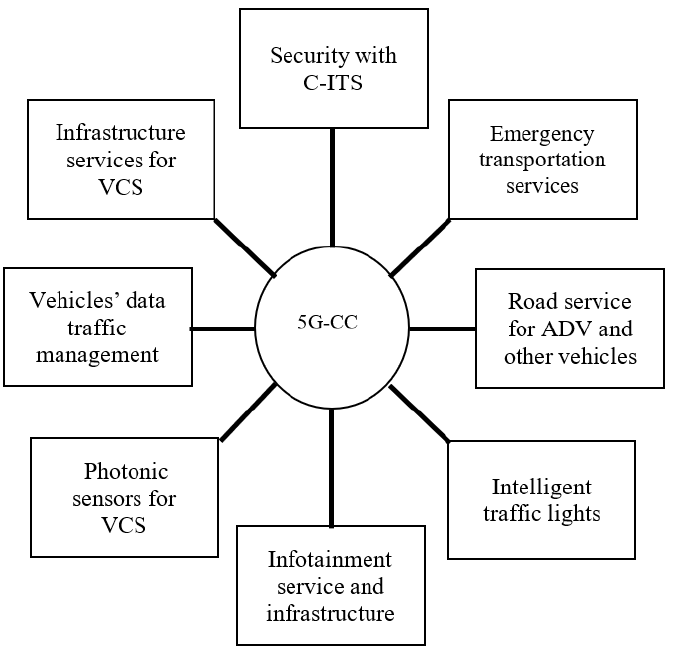
Figure 1. Transportation services with 5G cellular connectivity.